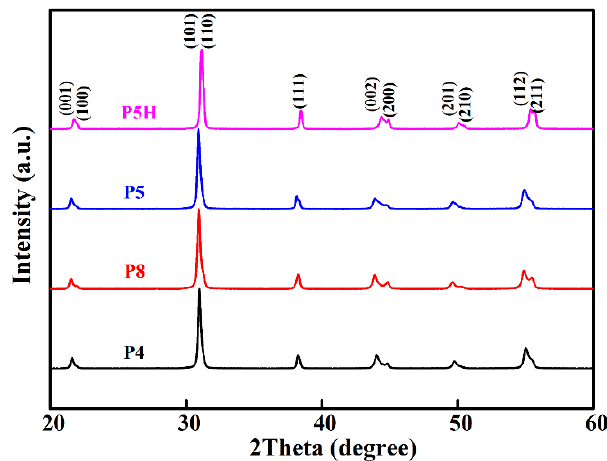
Figure 1. XRD patterns of the hard and soft Pb(Zr,Ti)O 3 (PZT) ceramics.